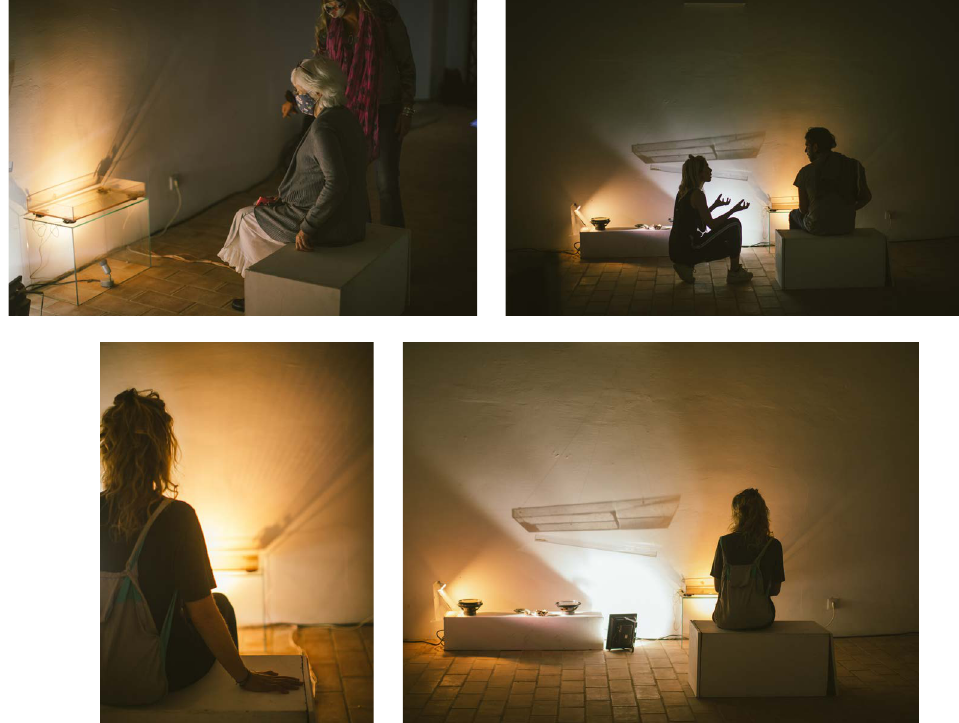
Figures 22 to 25: DIS_turbation. Audience experiencing the vibrations. © Isla